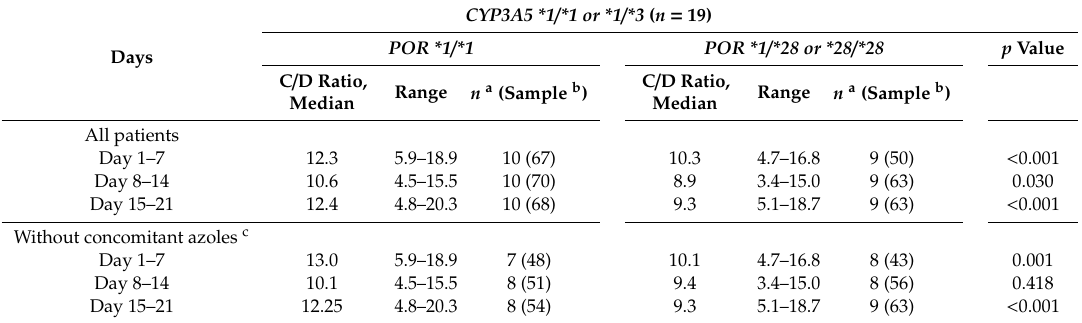
Table 3. Day + 1 to day + 21 median tacrolimus C / D ratio of CYP3A5*1 / *1 and CYP3A5 * 1 / *3 carriers according to POR genotype combinations ( n = 19).